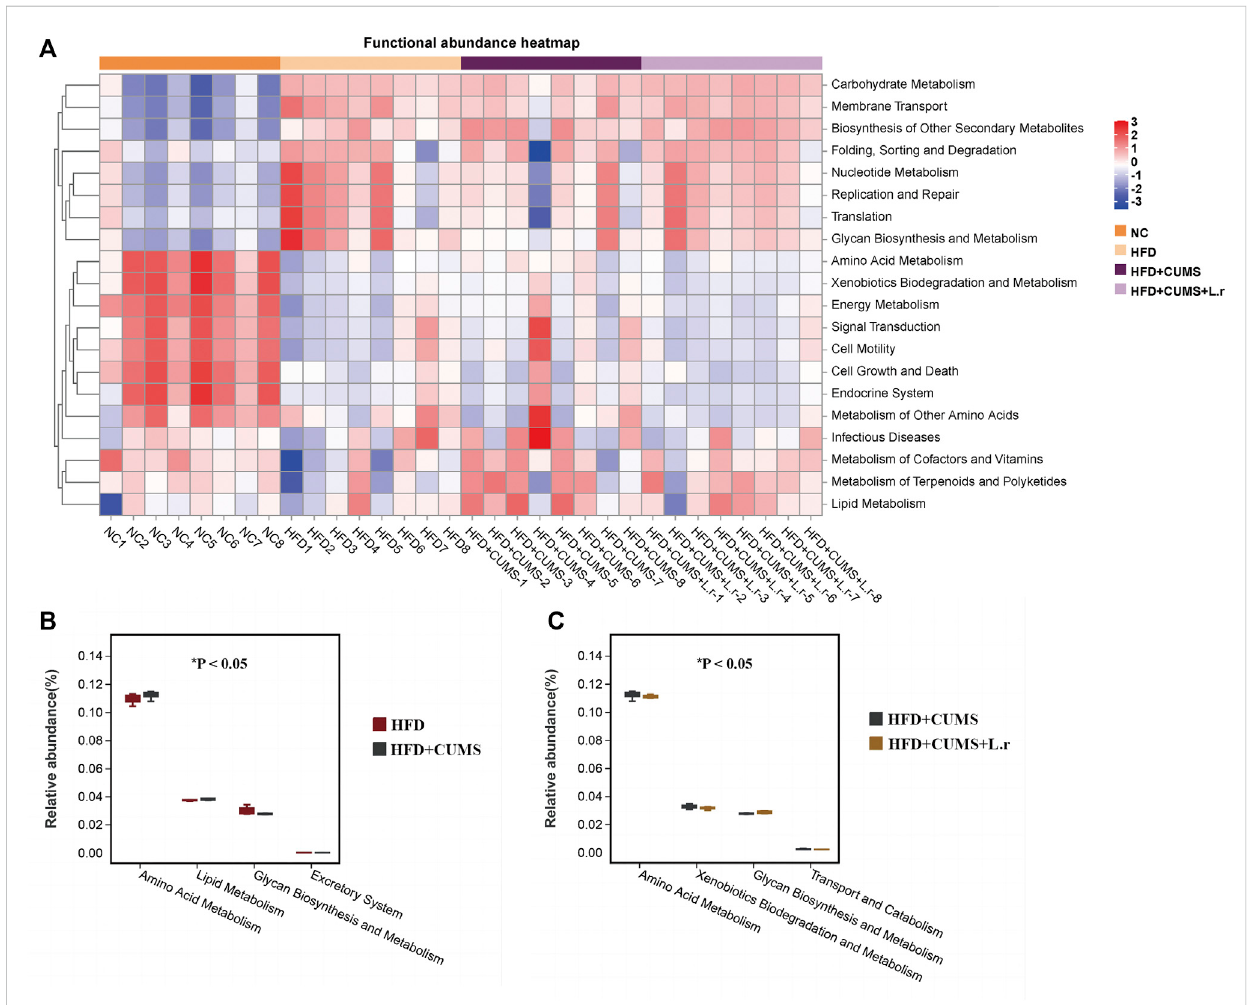
Tax4Fun bacterial community ’ s functional predictions ( n = 8/group). (A) Functional annotation clustering heat map using Tax4Fun on level 2. (B) Functional annotation relative abundance between the HFD and HFD + CUMS groups on level 2. (C) Functional annotation relative abundance between the HFD + CUMS and HFD + CUMS + L.r groups on level 2. (Statistical comparisons between the two groups were performed using the Wilcoxon rank